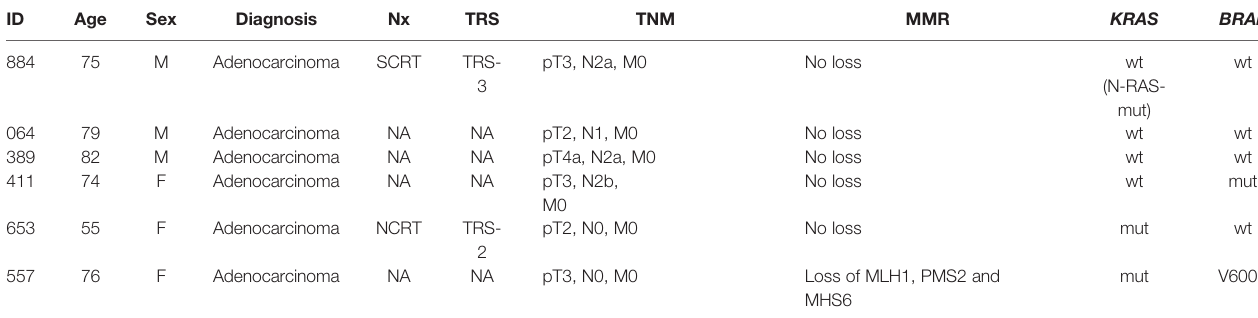
TABLE 1 | Clinicopathological characteristics of the parent tumours from which the six PDO lines were